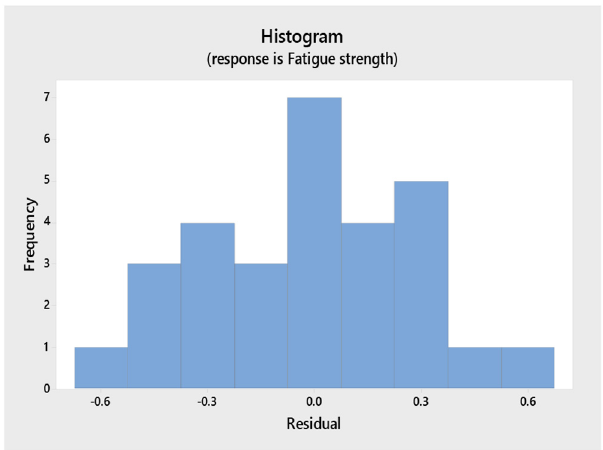
Fig. 10. Plot for residual versus data